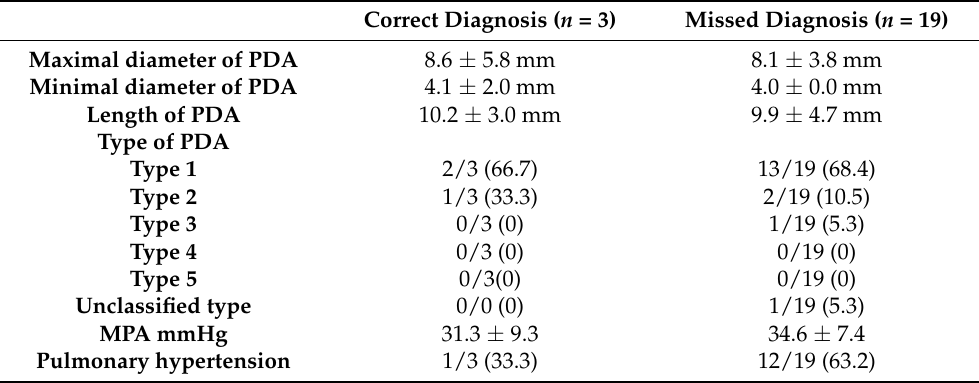
Table 4. CT findings between the patients with correct diagnosis and those with missed diagnosis of PDA in the group 2.